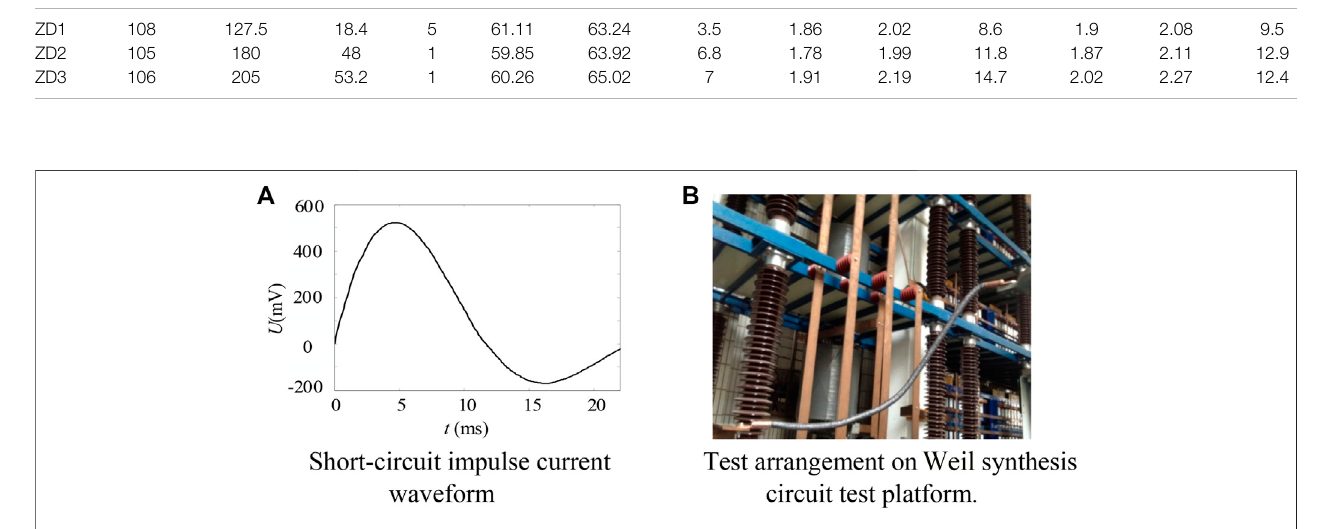
FIGURE 8 | Impulse withstand test with short-circuit